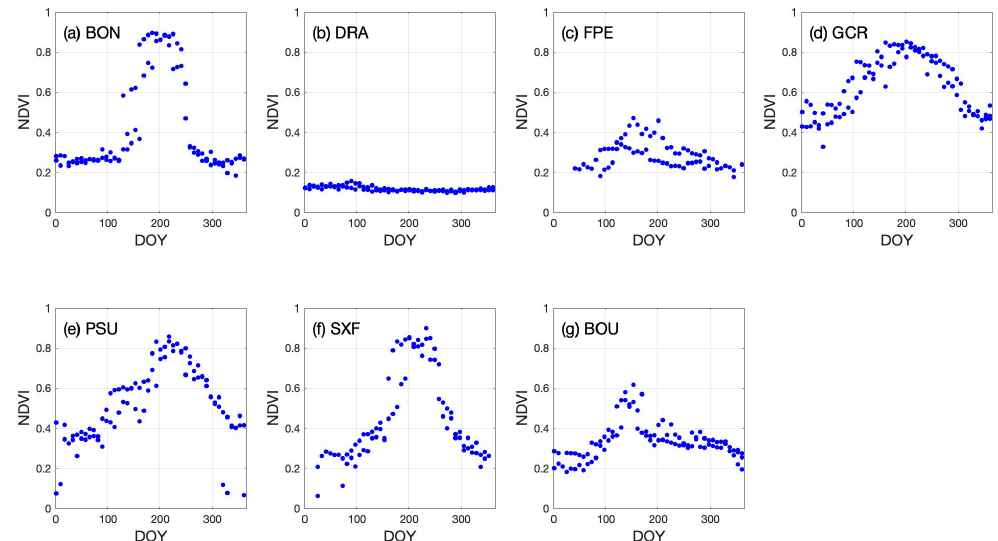
Figure 7. NDVI data for seven SURFRAD sites at the year of 2017 and 2018. ( a ) BON. ( b ) DRA. ( c ) FPE.